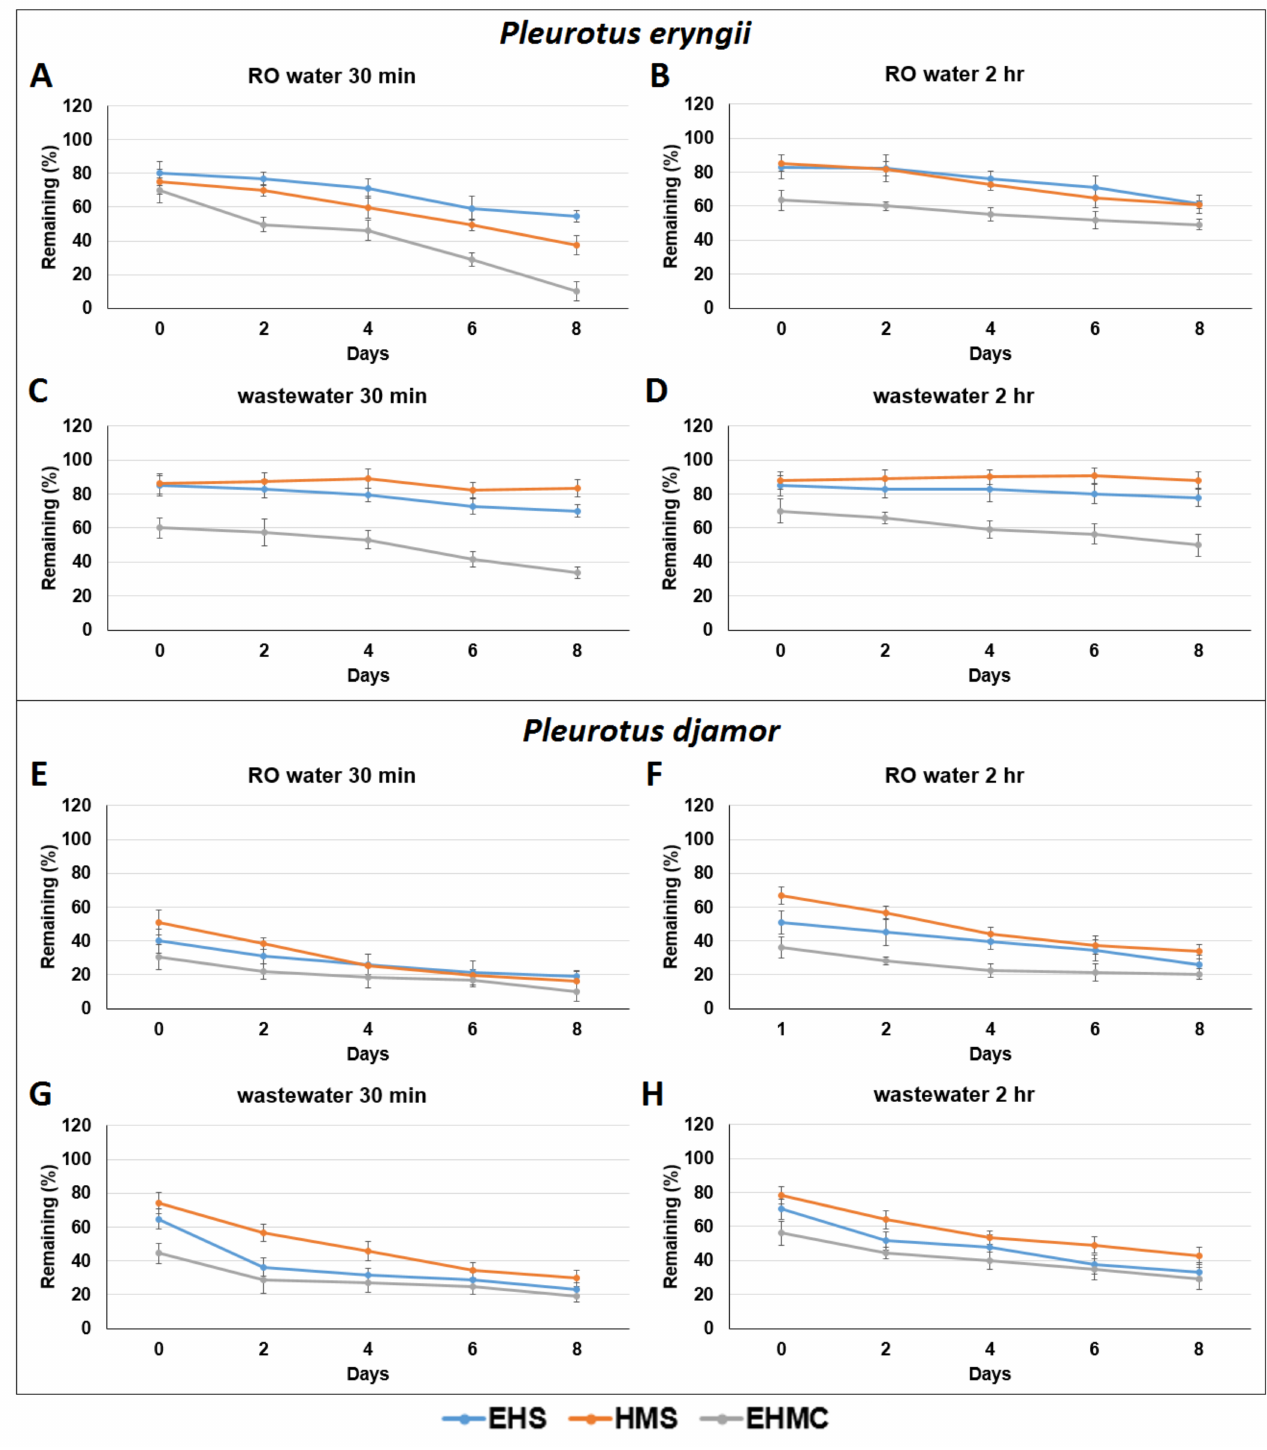
Figure 7. Bioreactor experiments simulating UV filter (20 ppm) removal in reverse osmosis (RO) filtration water ( A , B , E , F ) and wastewater ( C , D , G , H ) using the spent mushroom compost of two mushrooms ( Pleurotus eryngii ( A – D ) and Pleurotus djamor ( E – H )). Data from triplicate experiments are presented as the mean ± SE. EHMC: ethylhexyl methoxycinnamate, EHS: 2-ethylhexyl salicylate, HMS: